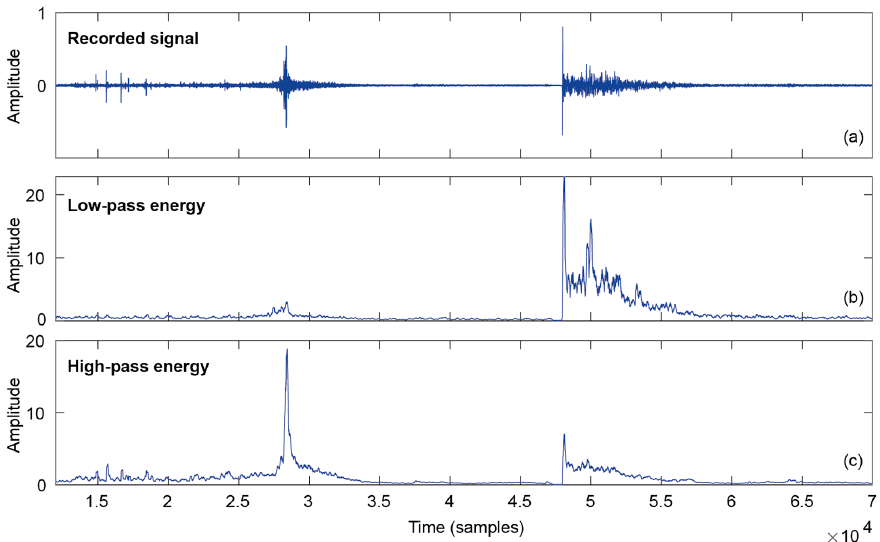
Figure 3. The recorded audio signal of a jump execution and filtered versions to enhance take-off and landing events. ( a ) Waveform; ( b ) low-pass energy; ( c ) high-pass energy.